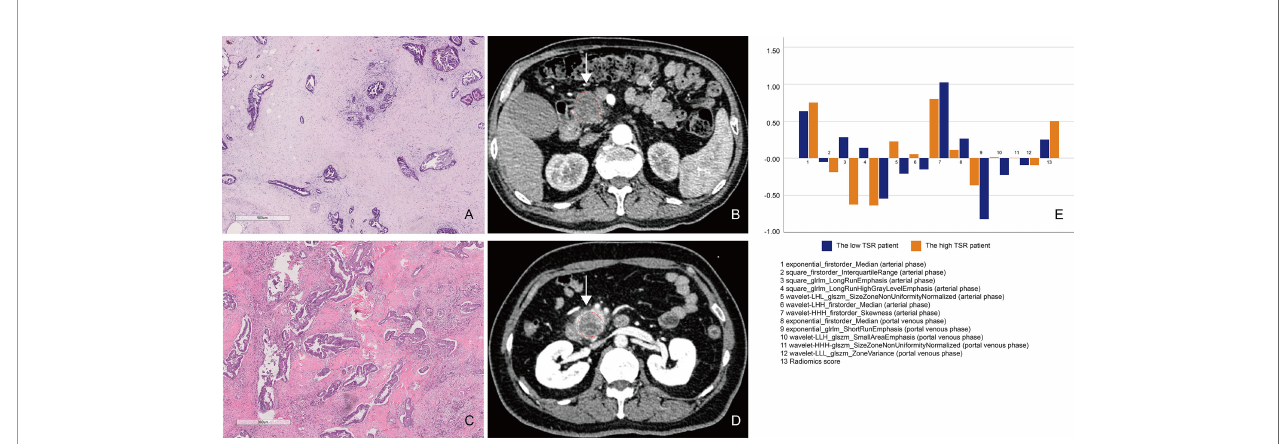
FIGURE 5 | A comparison between patients with low and high tumor – stroma ratio (TSR). (A, B) Patient 1: A 69-year-old man with PDAC in the TSR-low group. (A) Low TSR expression (×10). (B) The axial portal-phase computed tomography (CT) image shows an in fi ltrative, low-attenuation mass (arrows) located at the pancreatic body and tail. (C, D) Patient 2: A case of a 42-year-old woman with PDAC in the TSR-high group. (C) High TSR expression (×10). (D) The axial portal- phase CT image shows an in fi ltrative, low-attenuation mass (arrows) located at the pancreatic body and tail. (E) The comparison of the 13 radiomics features between patient 1 and patient